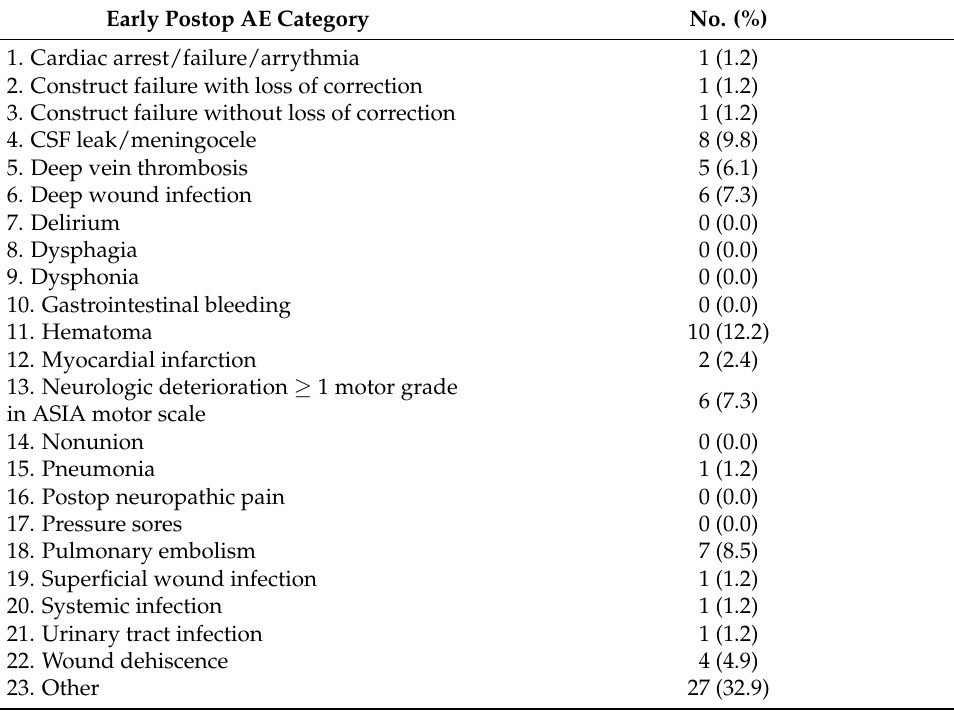
Table 5. Early post-operative complications.